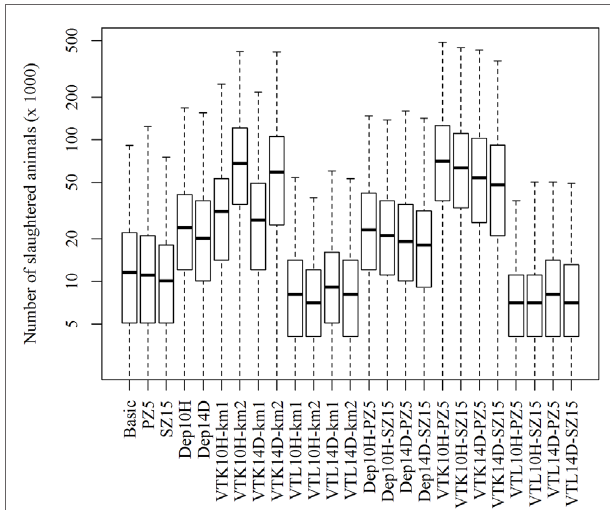
FigUre 1 | numbers of slaughtered animals using different strategies to control 1,000 simulated FMD epidemics in Denmark, all initiated in cattle herds . The basic scenario represents the EU and Danish control measures (Basic), combined with the enlargement of the protection zone to 5 km (PZ5) and the surveillance zone to 15 km (SZ15), pre-emptive depopulation (Dep) over a 1-km radius around detected herds, and suppressive (VTK) or protective (VTL) emergency vaccination over a 1- or 2-km radius around detected herds. Pre-emptive depopulation and vaccination were initiated either following the detection of 10 infected herds (10H) or after 14 days (14D) from the detection of the first infected herd. Scenarios combining pre-emptive depopulation over 1 km, suppressive or protective emergency vaccination over 2 km and enlarged protection or surveillances zones are also